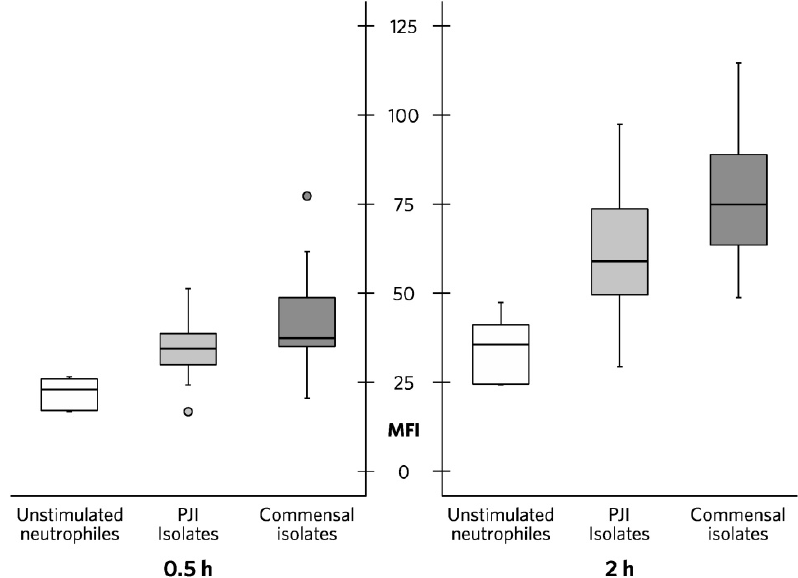
Figure 2. Active caspase-1 in neutrophils from three healthy controls after 0.5h and 2h of stimulation. White bars = unstimulated neutrophils, light grey bars = neutrophils stimulated with S. epidermidis isolates from prosthetic joint infections (PJIs), dark grey bars = neutrophils stimulated with S. epidermidis isolates from normal skin flora (commensal